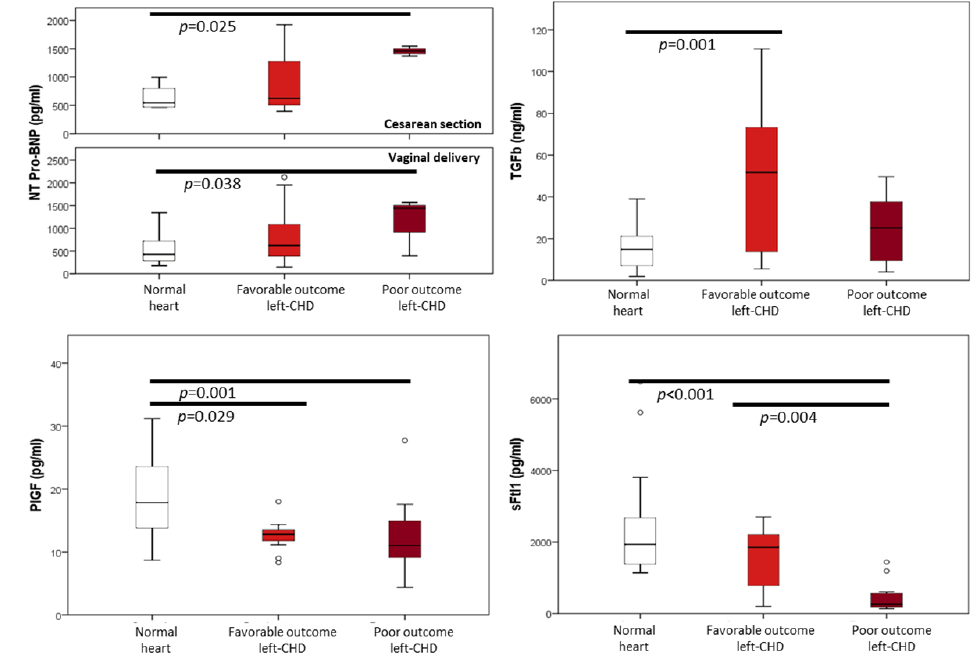
Figure 2. Concentrations of N-terminal precursor of B-type natriuretic peptide (NT-Pro-BNP), Troponin I, transforming growth factor β (TGF β ), placental growth factor (PlGF), and soluble fms-like tyrosine kinase-1 (sFlt1) in the cord blood of fetuses with normal heart and with favorable and poor outcome left congenital heart defects. Poor cardiac outcome is defined as univentricular circulation, heart transplant, or death. p -values are shown for significantly different ( p < 0.05) comparisons. Logistic regression analysis and evaluation of ROC curves of concentration of cord blood biomarkers for the prediction of outcome in fetuses with expected biventricular repair, adjusted for cardiac anatomy and cesarean section, found that only sFlt1 was useful as an outcome predictor. The sFlt1ROC curve had an AUC of 0.848 (95% confidence interval 0.706–0.991) with a cutoff value of 1520.7, having a specificity of 100% and a sensitivity of 72% for a favorable outcome (Figure